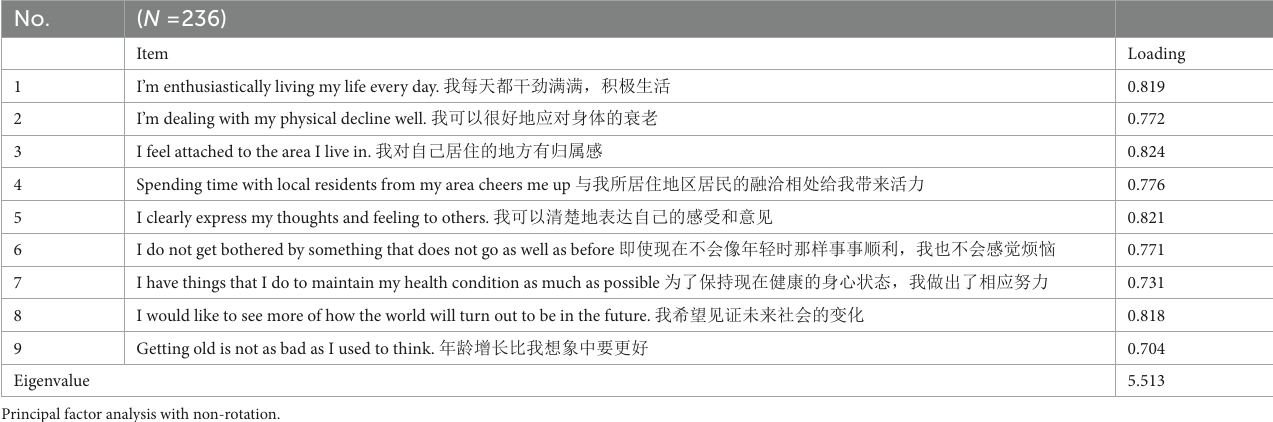
TABLE 5 Results of the exploratory factor analysis of RSO. No.